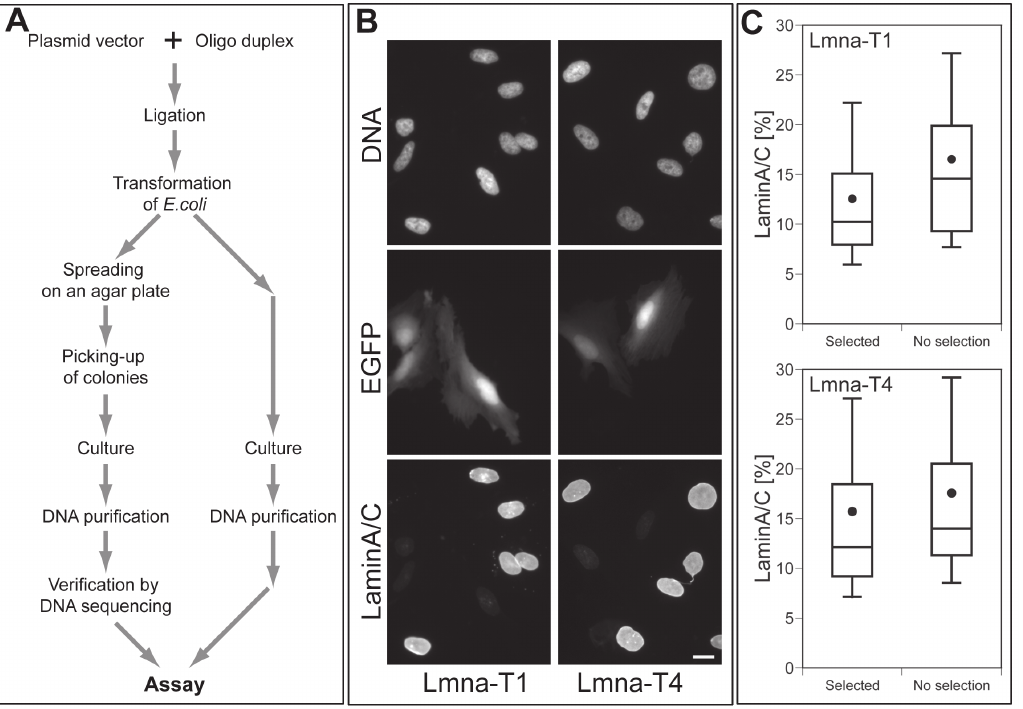
Figure 4. Improved shRNA expression plasmid preparation and demonstration of efficacy. ( A ) The left flow indicates the conventional method of expression plasmid preparation including colony-selection and DNA sequencing. The right flow indicates the novel method using plasmid vectors with the negative selection marker ( ccdB ). The ccdB gene allows growth of bacteria containing plasmid with insertion of oligonucleotides, but not growth of the parent plasmid vectors. As a result, plasmid DNA can be purified from heterogeneous bacterial culture after transformation without colony-selection and DNA sequencing. ( B ) Immunofluorescence of lamin A/C in HeLa cells. HeLa cells were transfected with pSHIN-G-Lmna-T1 or -T4 prepared by the “no selection” method (the right flow in A ). DNA-staining, EGFP and immunofluorescence of lamin A/C are shown. Reduction of lamin staining for cell expressing EGFP indicates knockdown. Bar, 20 µm. ( C ) Box plots of the lamin A/C levels [%] of HeLa cells transfected with shRNA expression plasmids. The top, bottom, and line through the